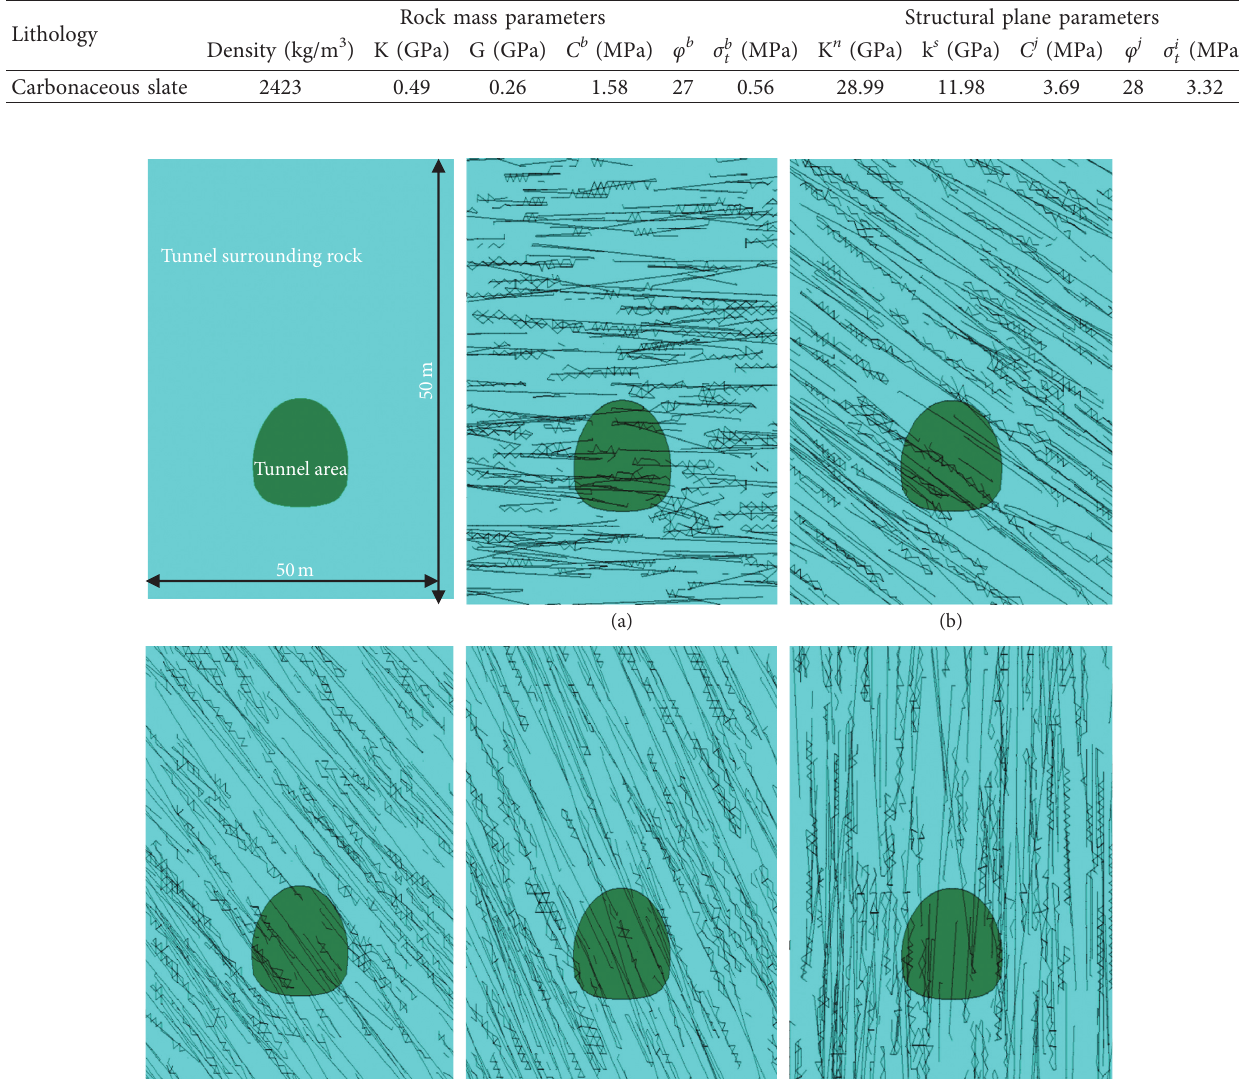
Table 2: Mechanical parameters of carbonaceous slate.